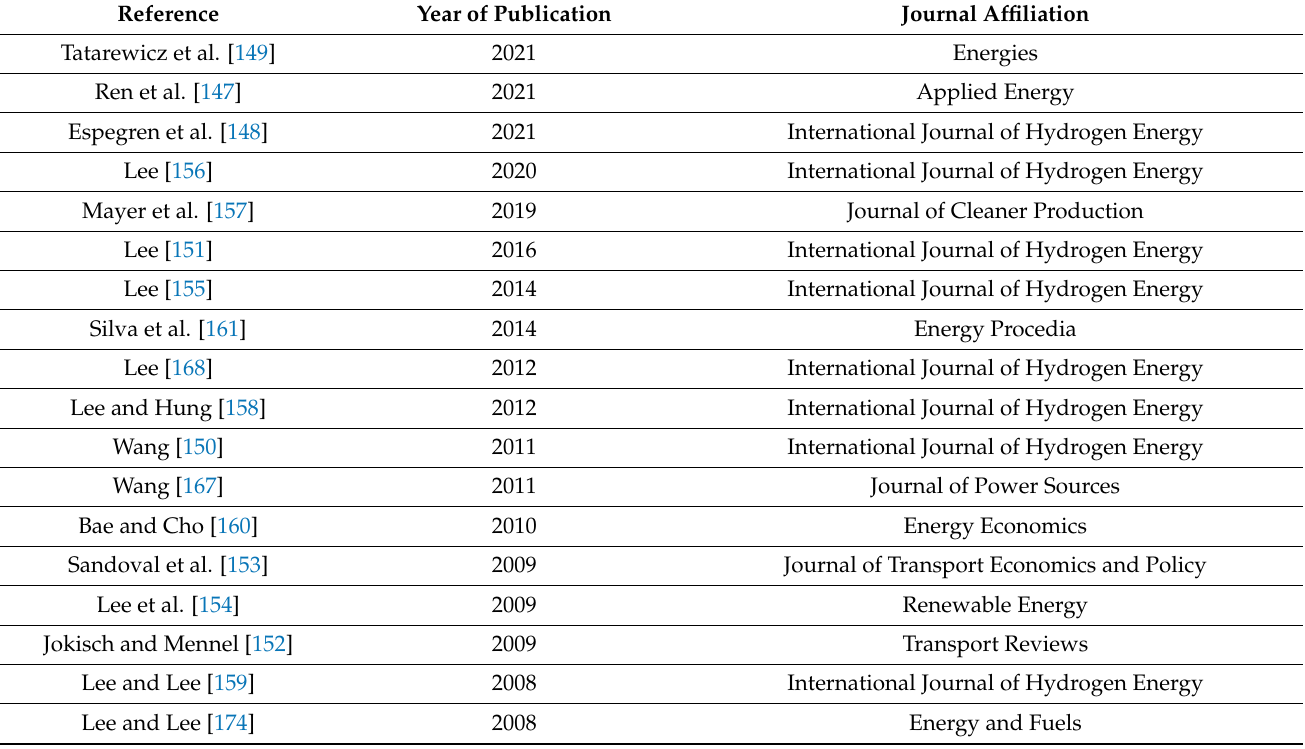
Table A1. Overview of studies applying computable general equilibrium models in the context of